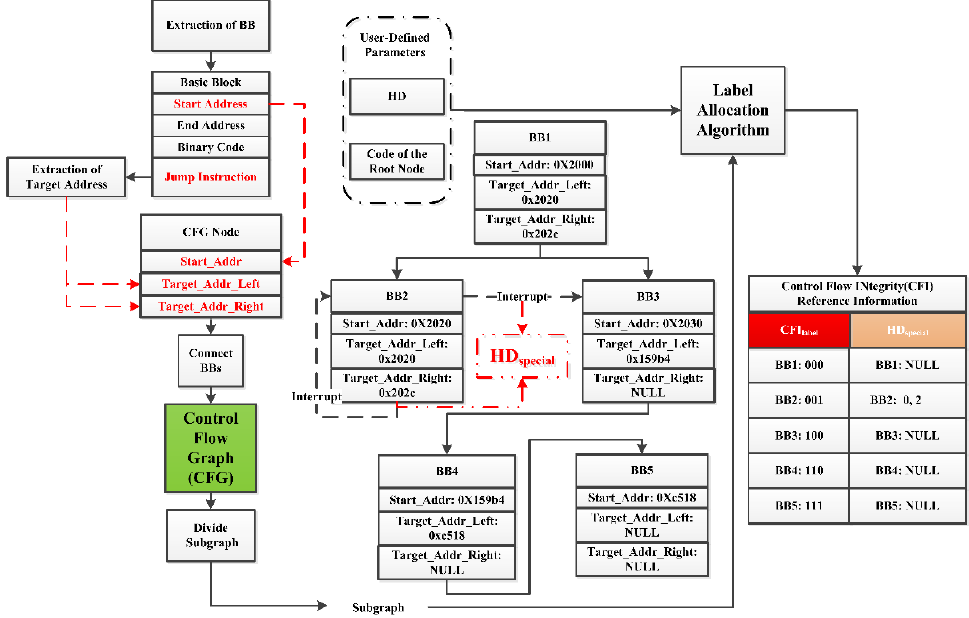
Figure 4. Extracting the control flow integrity reference information of BasicMath.